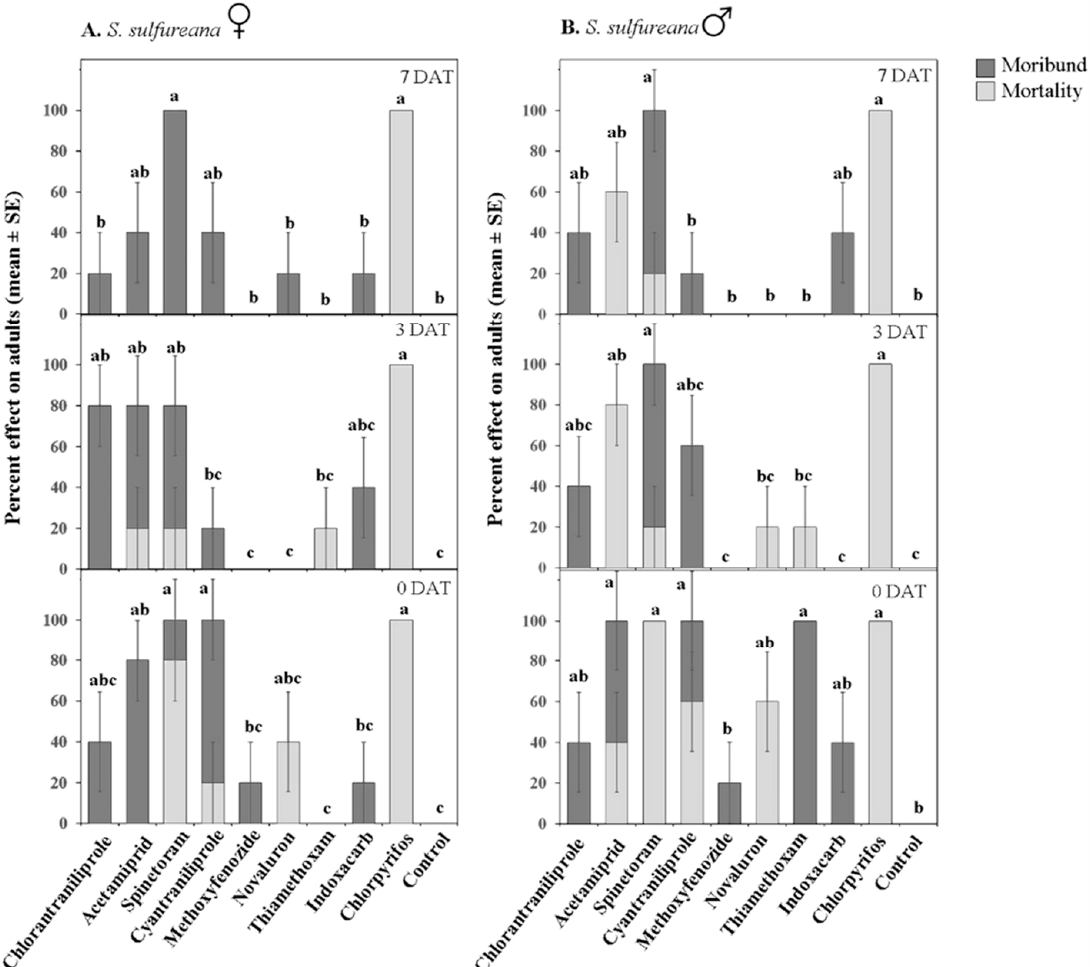
Figure 4. Effect of various insecticides on Sparganothis sulfureana adult females ( A ) and males ( B ) after exposure to 2 h (0 DAT), 3 DAT, and 7 DAT laboratory-aged residues. DAT = days after treatment. Dark portions of bars represent percent moribund ( i.e. , insects that were moving but failed to remain upright); light portions represent percent mortality ( i.e. , insects that exhibited no or very little movement when touched with a probe). Bars with the same letter are not significantly different at α = 0.05.